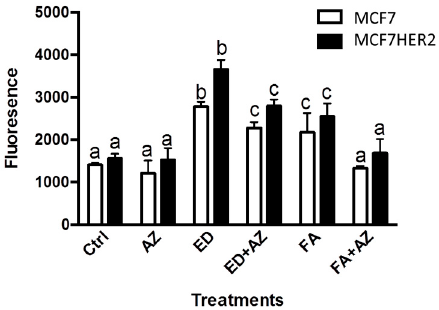
Figure 2. 17 β -estradiol induces cell proliferation in both MCF7 and MCF7HER2. Cells were incubated with 2 nM 17 β -estradiol (ED), 10 µ M ferulic acid (FA) and 100 µ M acetazolamide (AZ) and cell proliferation was measured as described in the Experimental Section. Boxplots show means ± SEM of 6 independent experiments. Values for the same cell line with different superscripts are significantly different ( p < 0.05) as determined by one way ANOVA with subsequent Tukey’s post hoc test. Metabolic profiles for hydrophilic and lipophilic extracts were measured for all three cell lines (MCF10A, MCF7 and MCF7HER2) under studied treatments, see spectra in Figure 3.